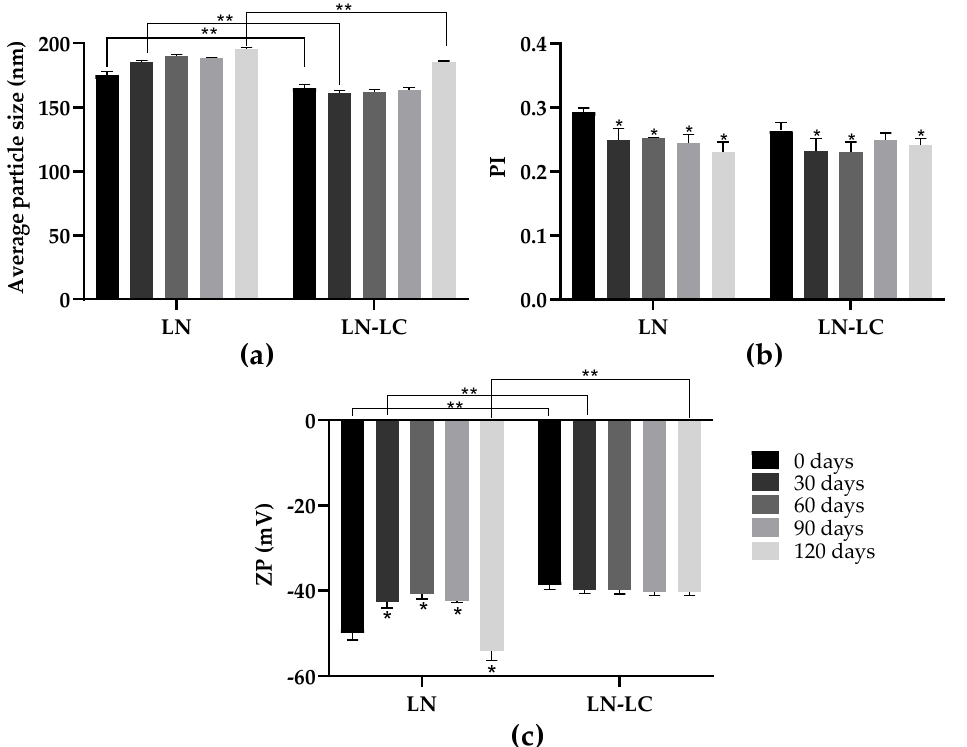
Figure 1. Average particle size (nm) ( A ), polydispersity index (PI) ( B ), and ZP (mV) ( C ) of synthesized LN, monitored at 25 ◦ C immediately after synthesis (0 days) and after 30, 90, and 120 days of storage. Results are expressed as mean ± SD (n = 3). Significant differences between 0 days and other periods for the same LN are represented by (*), p < 0.05 (ANOVA followed by Tukey test). Significant differences between unloaded LN and LN loaded with LC for the same period are represented by (**), p < 0.05 (two-way ANOVA, followed by Tukey’s test). The interaction of LC and LN was investigated by using the evaluation of entrapment efficiency (EE). Since LC is considered a poorly aqueous soluble compound (solubility in water = 0.005 mg L − 1 at 20 ◦ C), LN are suitable nanocarriers for LC encapsulation, showing a %EE of 98.44 ± 0.04. The high %EE can be attributed to the reduced particle size of synthesized LN and to the presence of liquid lipid (Capryol 90) in the LN structure, as this can favor the solubility of LC in the melted lipid matrix, as well as the formation of LN with a more amorphous structure to improve the LC entrapment. Thus, the synthesized LN showed good properties regarding average particle size, homogeneity, and surface charge, demonstrating that LN are excellent systems for LC